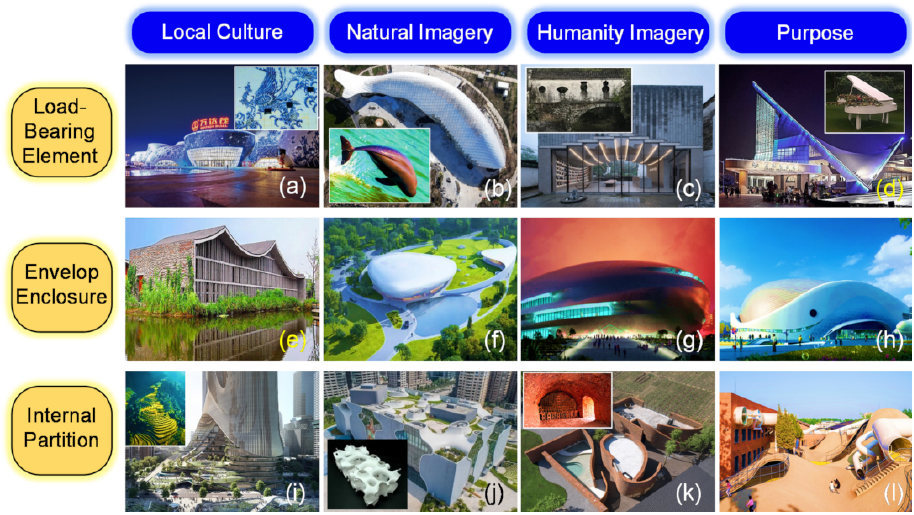
Figure 1. Classification of curved plates and typical architectural cases. Line 1: ( a ) Nanchang Wanda Mall blue and white porcelain buildings [41] and local pattern [42], ( b ) Yangzhou International Horticultural Expo-International Pavilion [43], ( c ) Shanghai Sanlian bookstore—Huangshan Taoyuan store [44], and ( d ) Guangzhou Xinghai Concert Hall; Line 2: ( e ) Building 14, School of Architecture, Xiangshan Campus, China Academy of Art [45], ( f ) Anaya “Cloud Centre” [46], ( g ) Shenzhen Science and Technology Museum [47], and ( h ) Harbin Polar Park [48]; Line 3: ( i ) Shenzhen Bay Super Headquarters Base C Tower [49] and typical Terraced fields in China, ( j ) Taichung Metropolitan Opera House [50] and the cave model [51], ( k ) Beijing Beigou village brick factory (b&B) [52] and typical brick kilns in China, and ( l ) Beijing the Playscape-Children’s Growth Centre